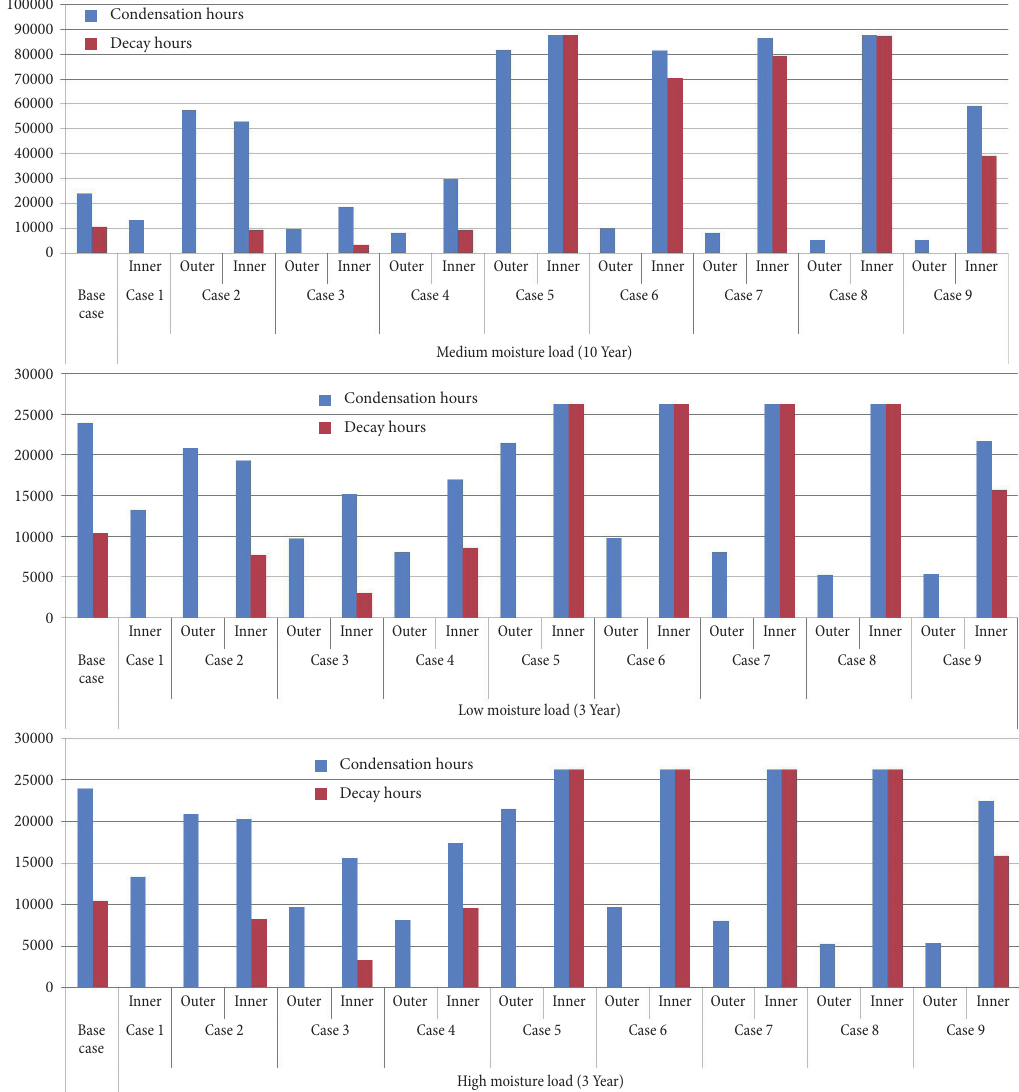
Fig. 5. Condensation and decay hours for installation Method 2 for various moisture loads